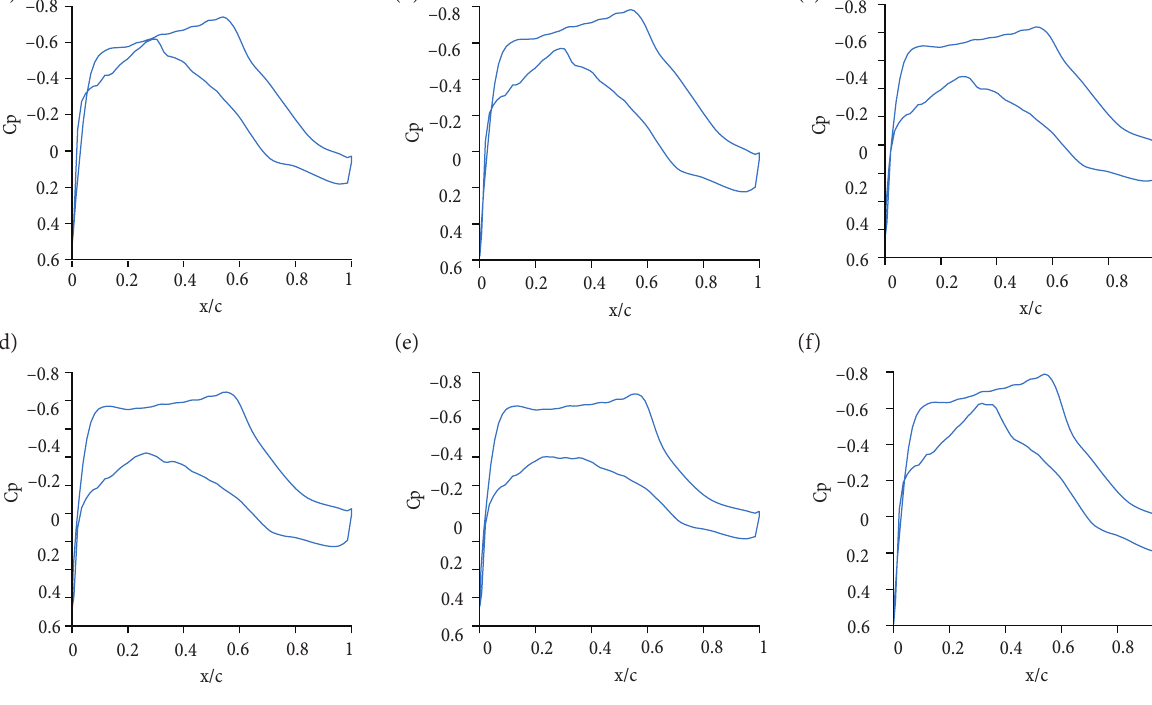
Figure 9. Pressure coefficient distribution on 2y/b = 0.69 spanwise section of the UAV at different response